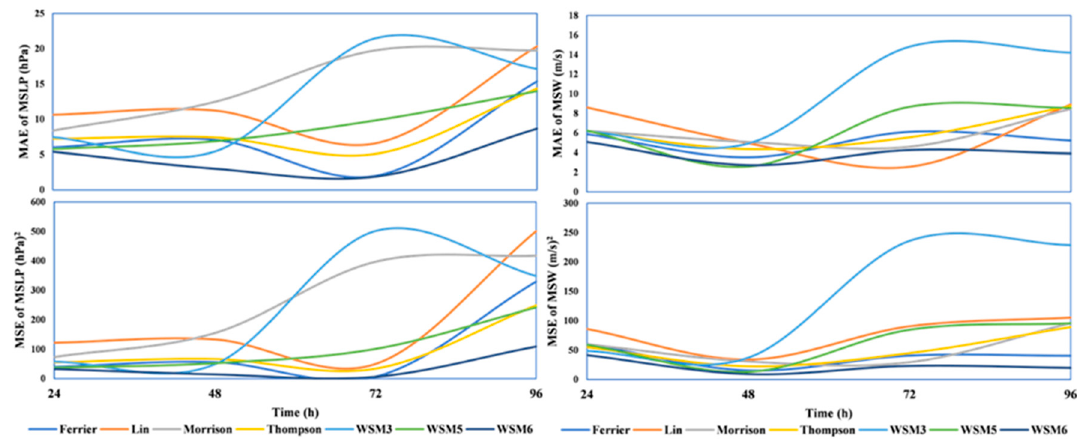
Figure 7. Mean Absolute Error (MAE), Mean Square Error (MSE) of Mean Sea Level Pressure (MSLP) and Maximum Sustained Wind (MSW) of the tropical cyclone Hudhud.